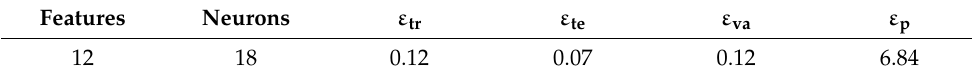
Table 5. Selected model results.